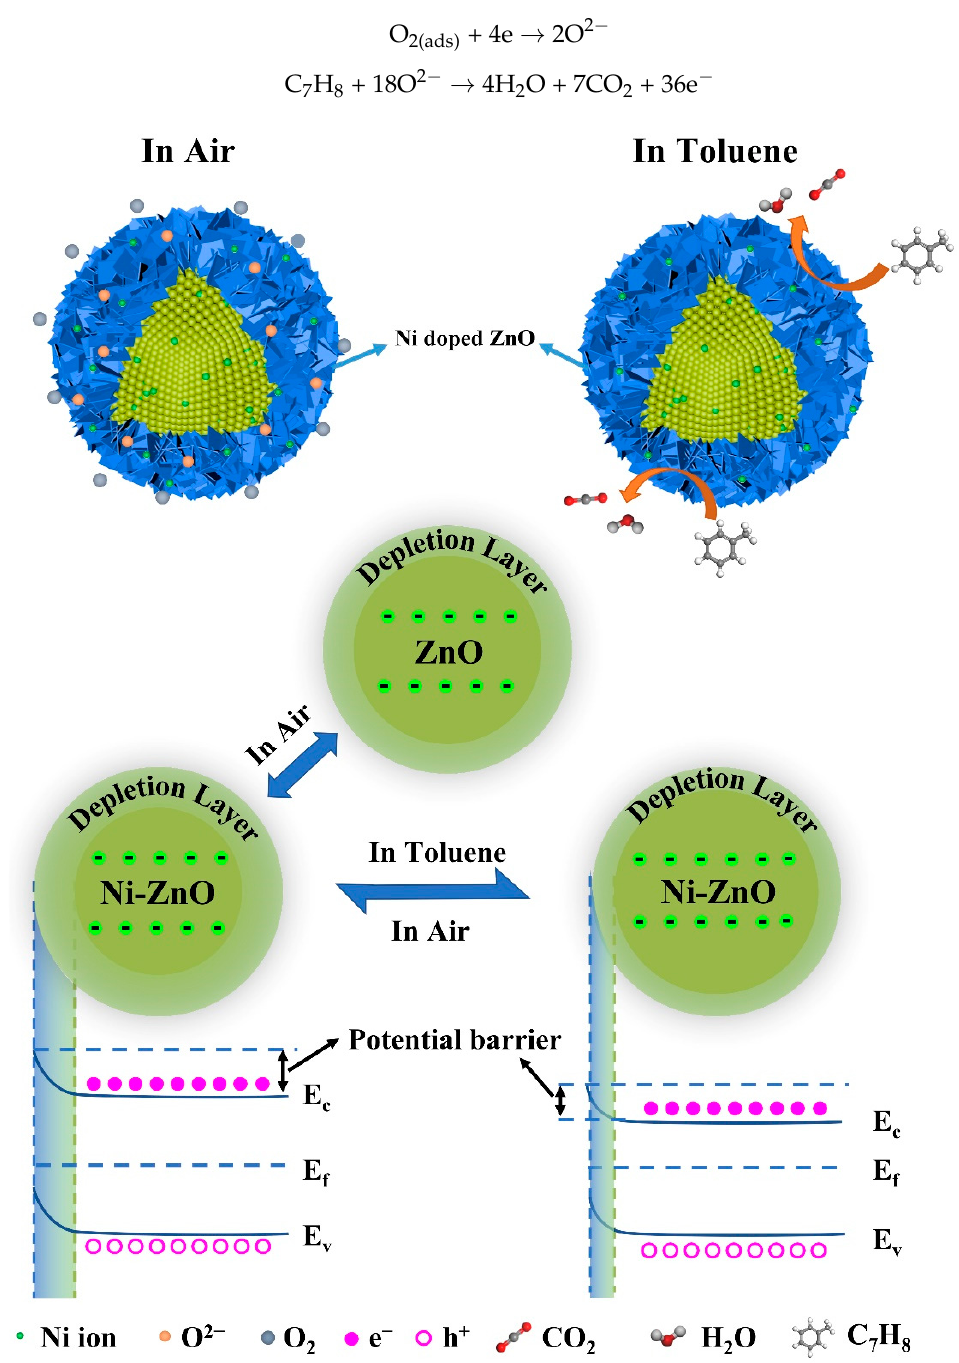
Figure 10. A schematic diagram of the sensing mechanism.